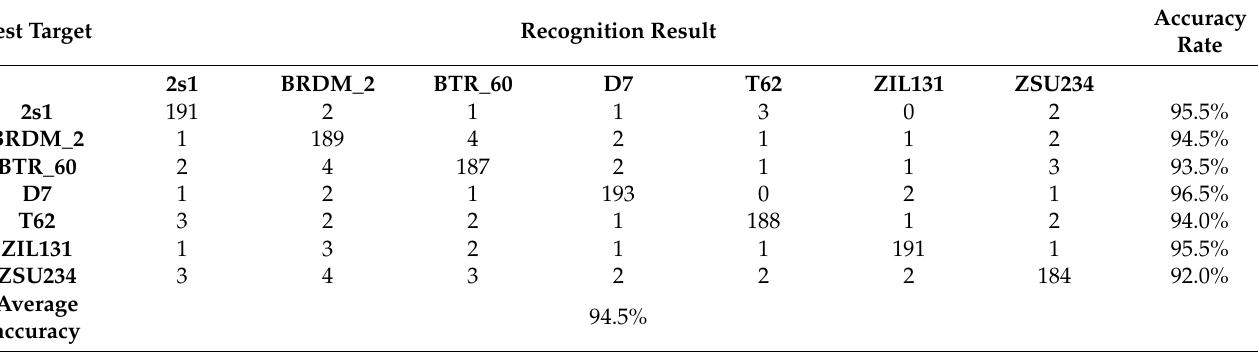
Table 9. Target recognition results with pretraining (mixed targets